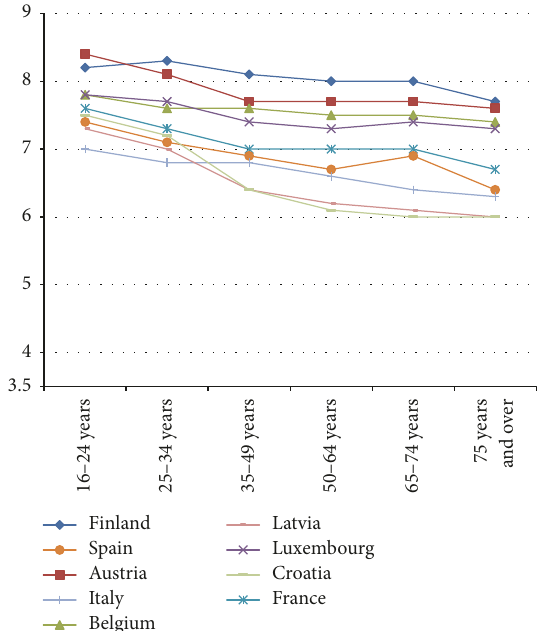
Figure 2: Relatively small decline in life satisfaction by age 2013.